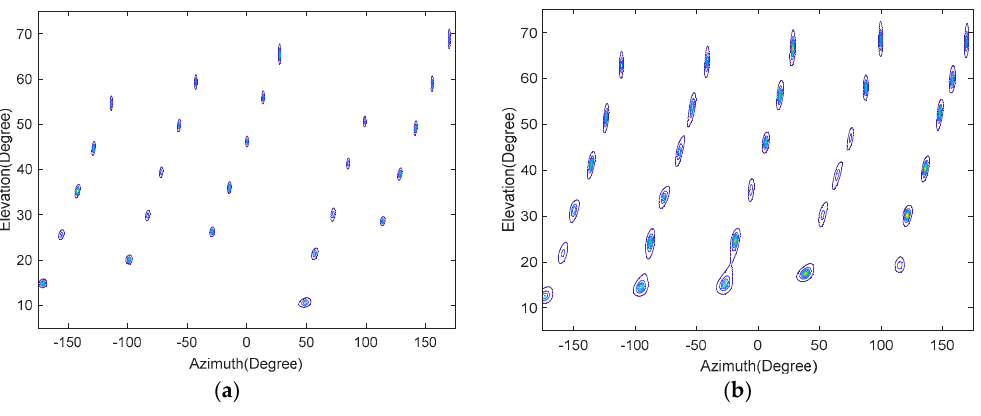
Figure 5. Spatial spectrum contour map ( a ) K = 25 ( b ) K = 30.